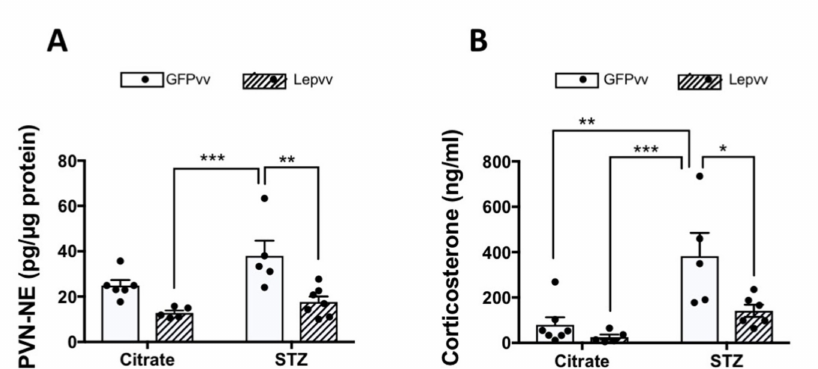
Figure 5. Effects of STZ-induced diabetes and leptin gene transfer on HPA axis activity. Citrate + GFPvv ( n = 7); STZ + GFPvv ( n = 6); Citrate + Lepvv ( n = 5) and STZ + Lepvv ( n = 7) are represented. Data were analyzed by 2-way ANOVA followed by Tukey’s multiple comparisons test. ( A ) Effects on NE concentrations in the PVN (pg/ µ g protein, mean ± SEM). Diabetic rats treated with GFPvv had higher concentrations of NE in the PVN than Lepvv-transfected rats (** indicates p < 0.01 and *** indicates p < 0.001). ( B ) Effects on serum corticosterone (ng/mL, mean ± SEM). Diabetic rats transfected with GFPvv had higher serum corticosterone levels compared to the rest of the groups. * indicates p < 0.05, ** indicates p < 0.01 and *** indicates p < 0.001.